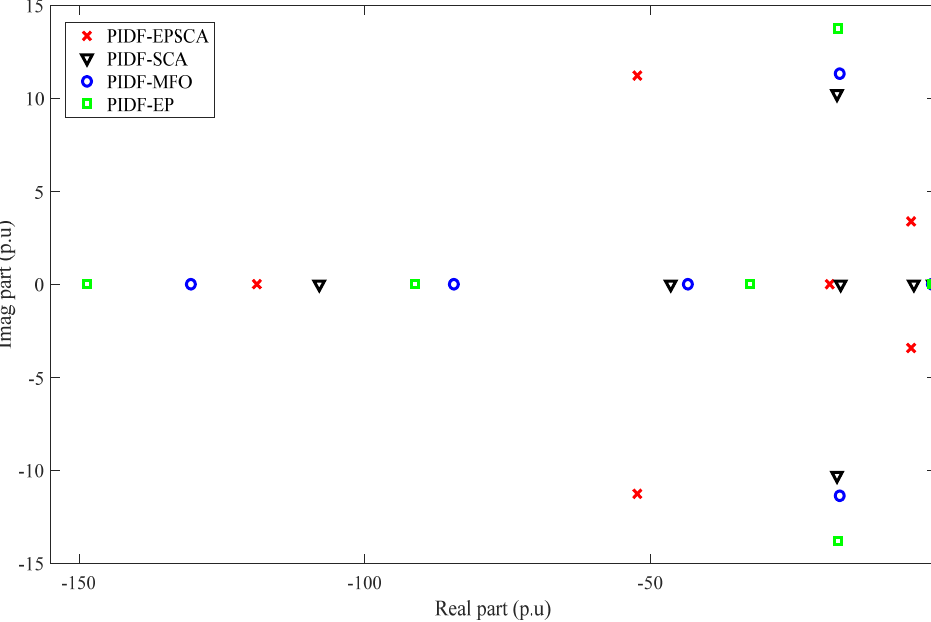
Figure 23. Eigenvalue distribution of TCSC-PIDF controller system using PIDF-EPSCA, PIDF-SCA, PIDF-MFO, and PIDF-EP techniques for Scenario A-3.